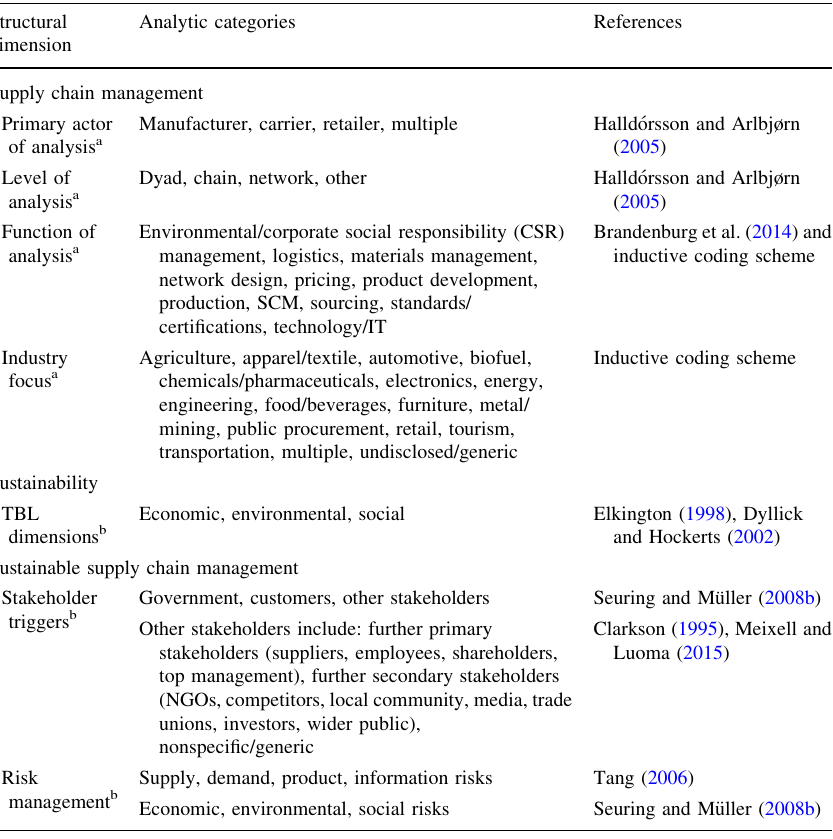
Table 2 Structural dimensions and analytic categories for the content analysis Structural